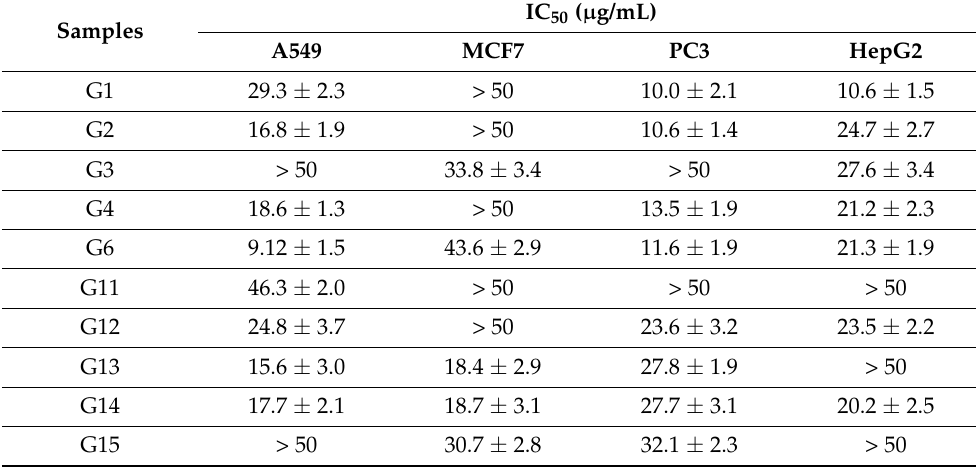
Table 2. In vitro cytotoxic activity of the methanol extracts on the five tumor cell lines measured by the MTT assay a